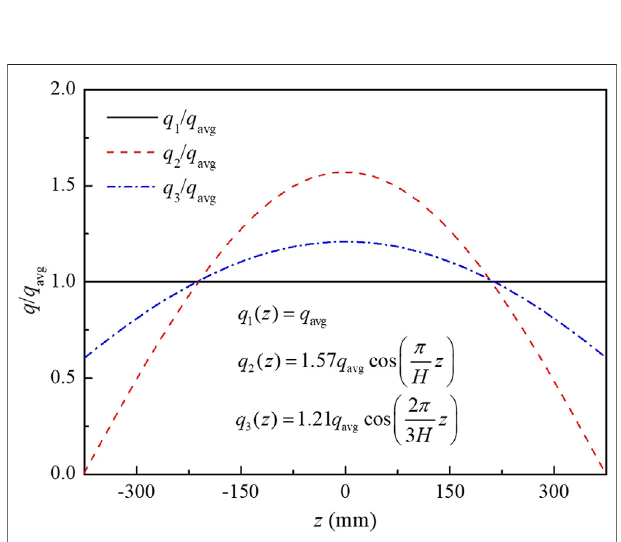
FIGURE 11 | Power density distribution along the height